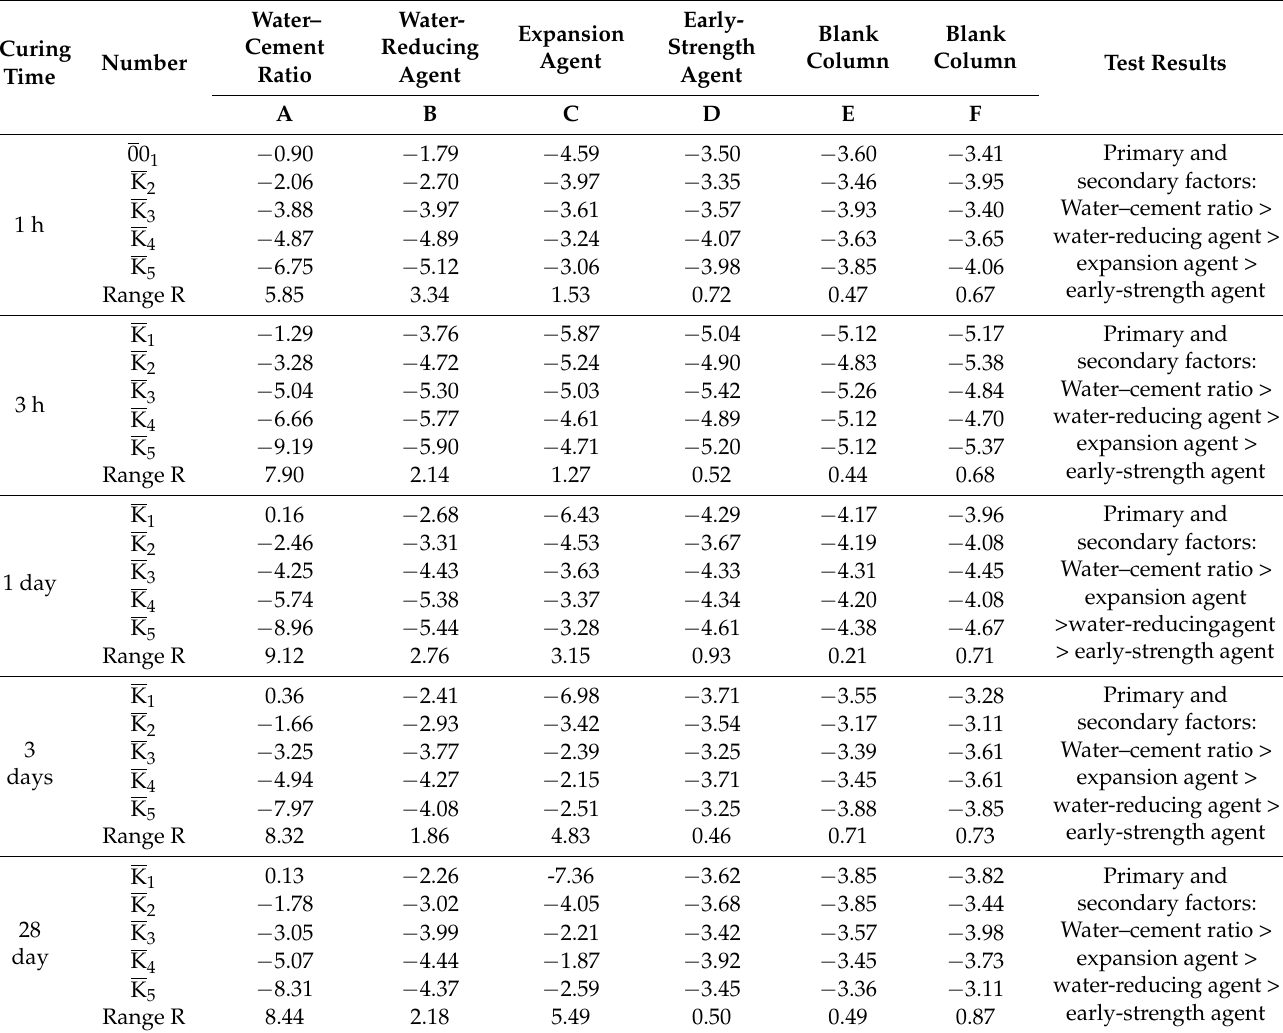
Table 6. Range analysis of orthogonal test results for the volume growth rate of the grouting